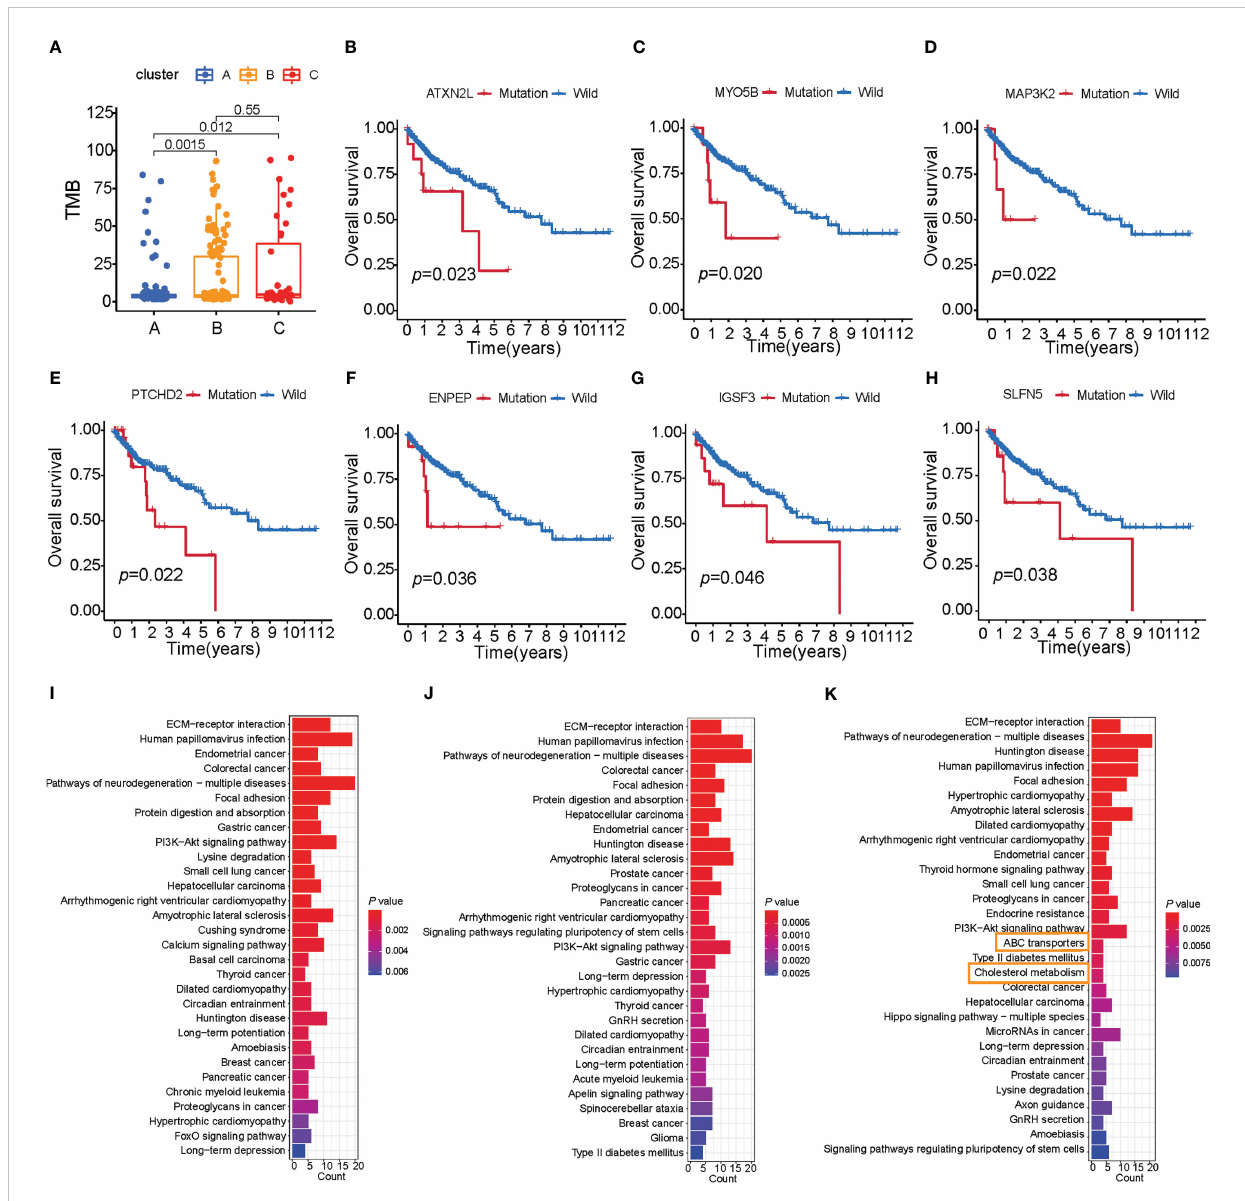
FIGURE 3 Characteristics of three subtypes of colon cancer in tumor somatic mutation. (A) TMB analysis (Wilcoxon test) of patient subtypes in TCGA-COAD cohort. (B – H) Survival analysis of key gene mutations (log-rank test). (I – K) The signaling pathway of the top 200 mutation genes enriched in three distinct